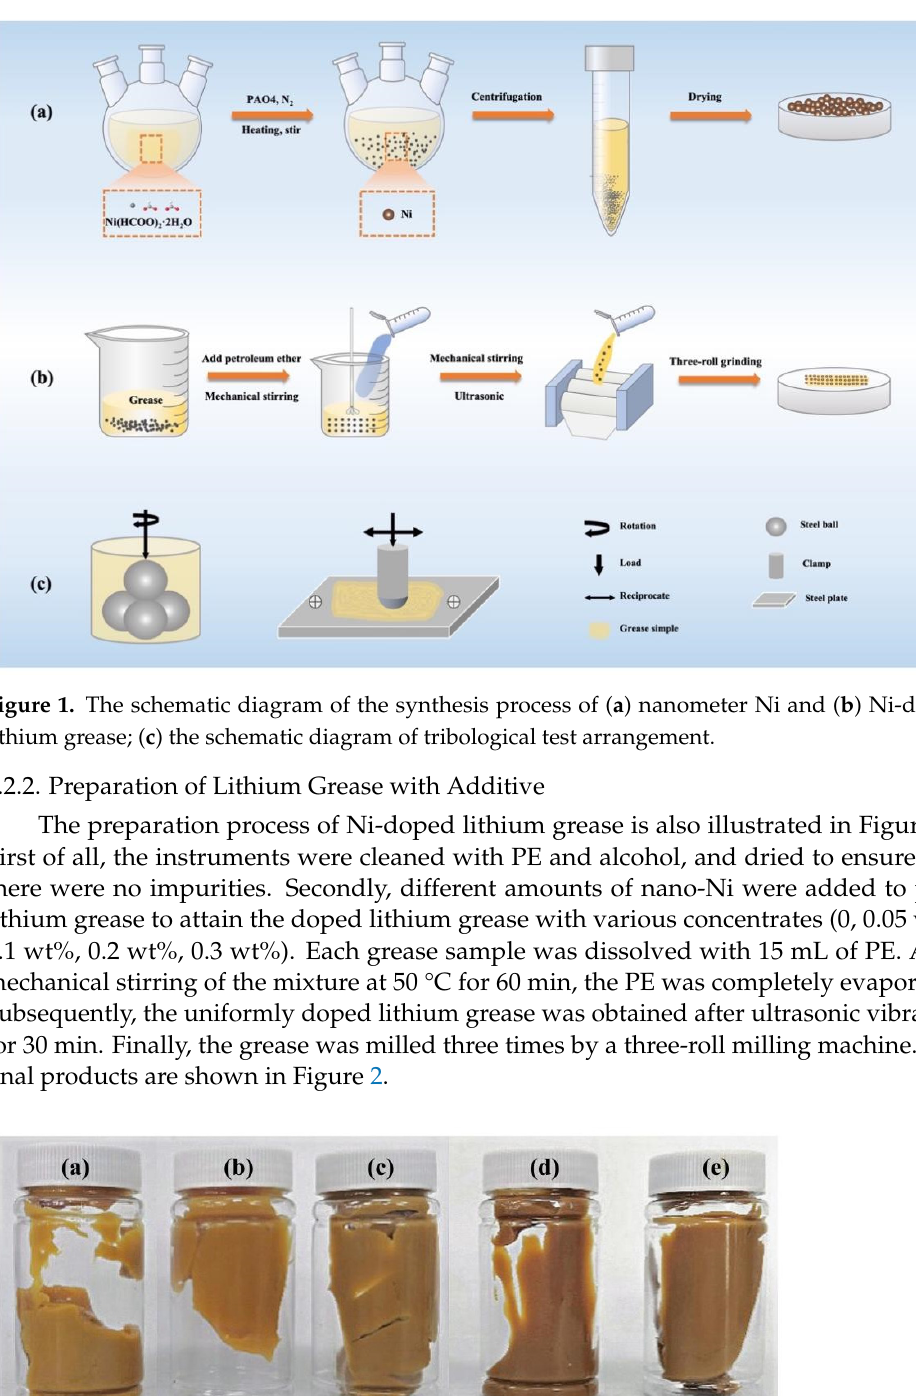
Figure 2. Lithium grease with nanometer Ni in various concentrations (wt%): ( a ) 0, ( b ) 0.05, ( c ) 0.1, ( d ) 0.2, ( e ) 0.3. ( d ) 0.2, ( e )